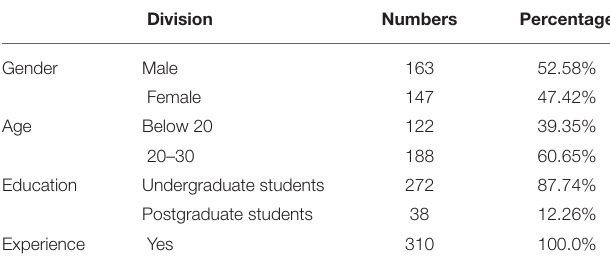
TABLE 1 | Sample characteristics.